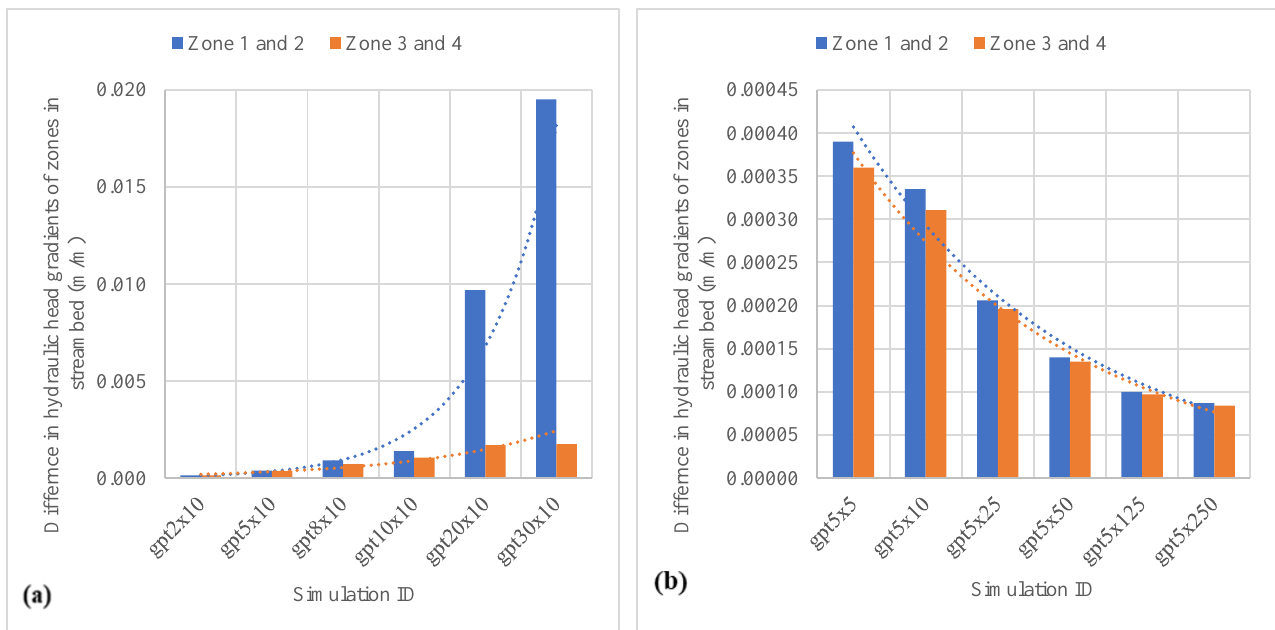
Figure 12. Change in the difference in HHGs of four zones with gravel and sand in the streambed with increasing height ( a ) and base width ( b ) of gravel pieces. Explanation of model setups can be found in the methodology chapter.